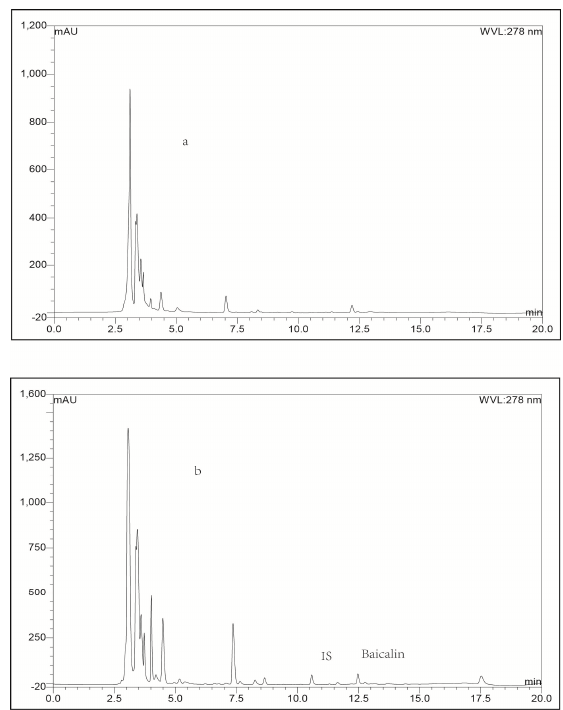
Figure 6. Representative LC-UV chromatograms obtained for blank spleen tissue ( a ) and spleen bio-sample collected from a rabbit at 0.25 h after intravenous administration of baicalin-loaded liposomes at a dose of 10 mg/kg + IS ( b ).